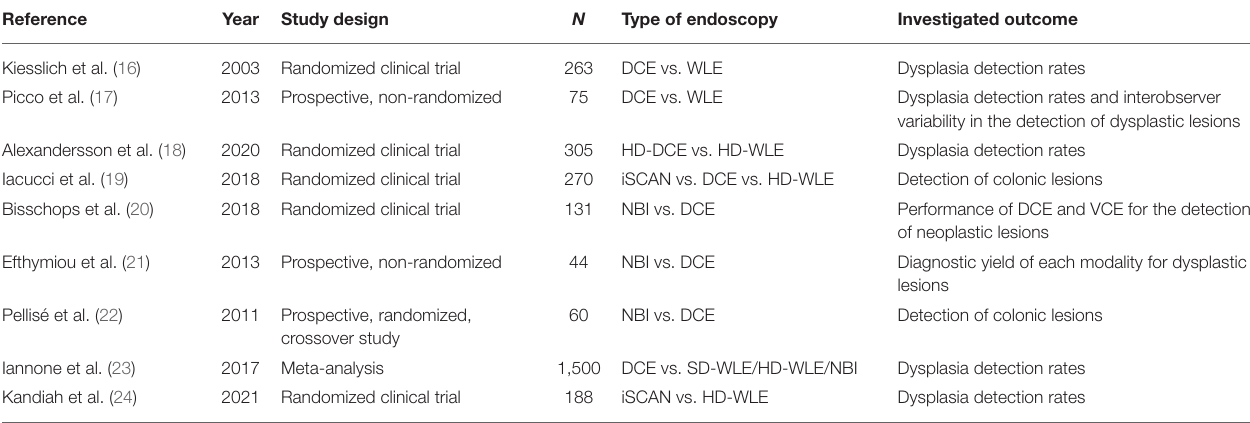
TABLE 1 | Studies investigating dysplasia detection rate in IBD with different endoscopic